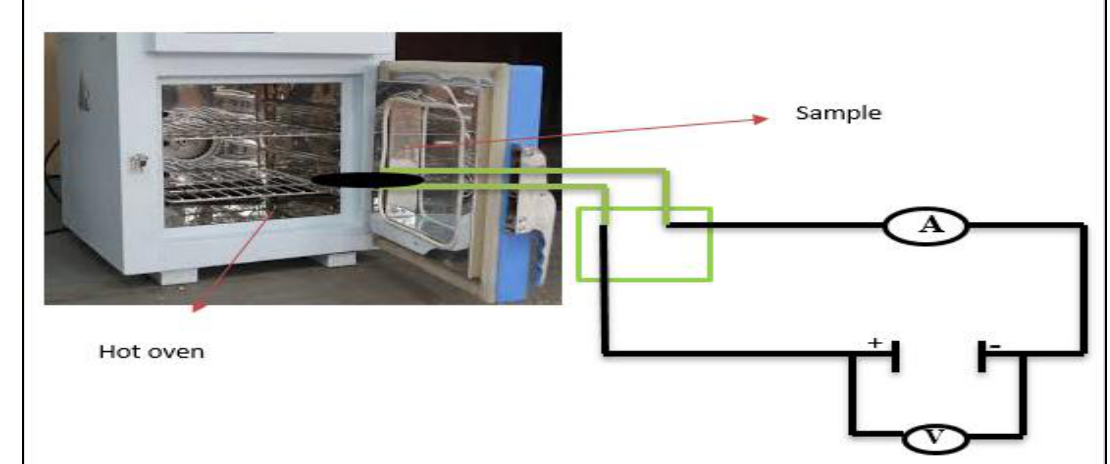
Fig.4: Schematic diagram of the series circuit of DC measurement.